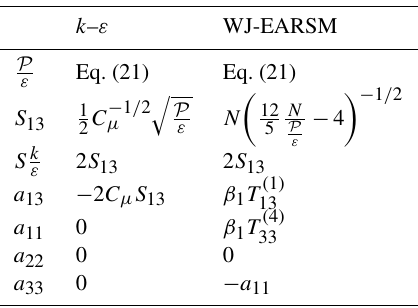
Table 3. Analytic, asymptotic homogeneous shear flow